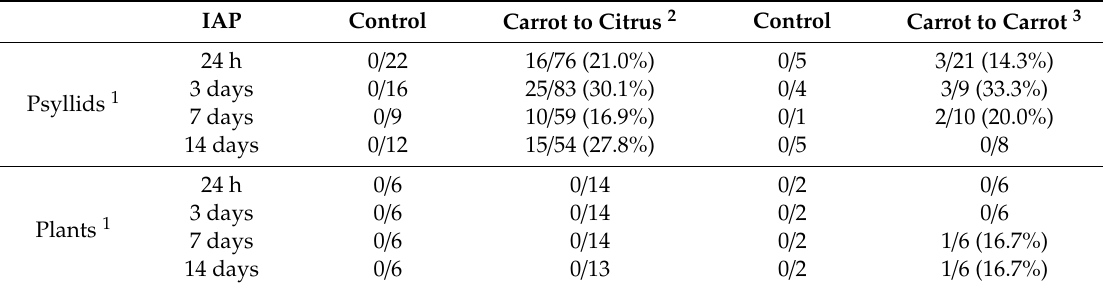
Table 4. Detection of CaLsol on T. erytreae individuals, carrot plants and citrus plants in restricted leaf exposure (clip cage plant) assays.